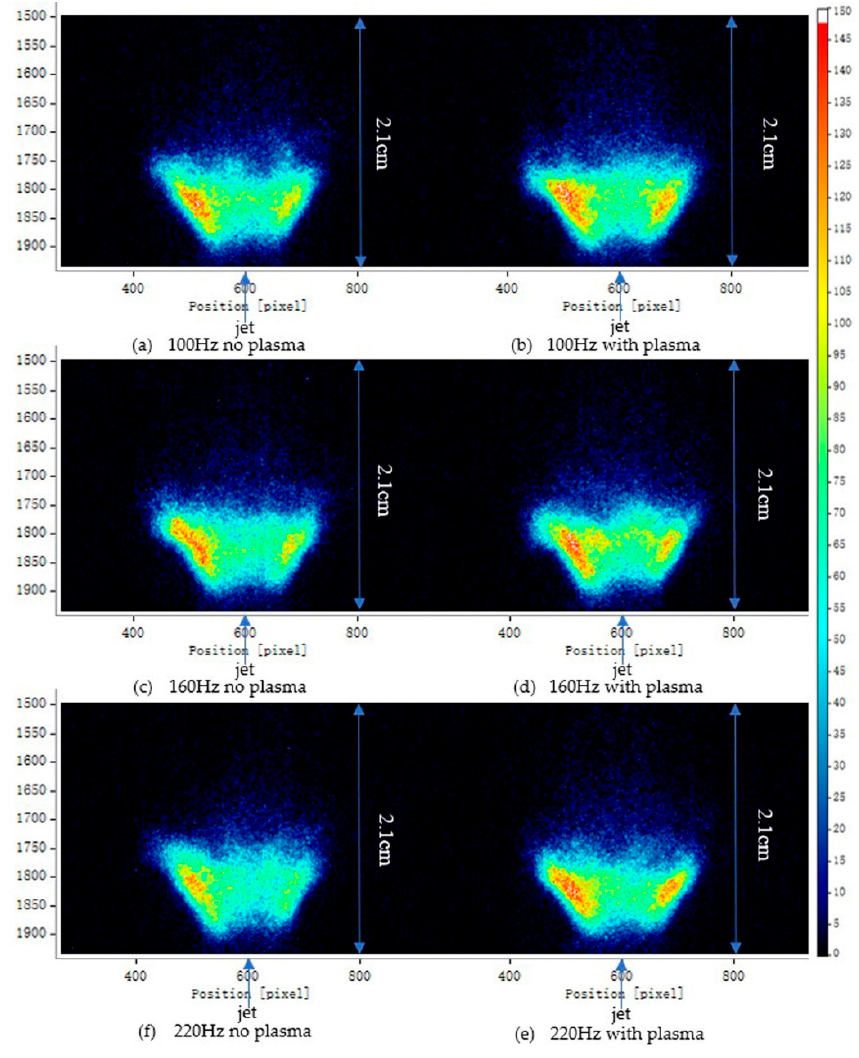
Figure 10. The effects of plasma on the flame front.